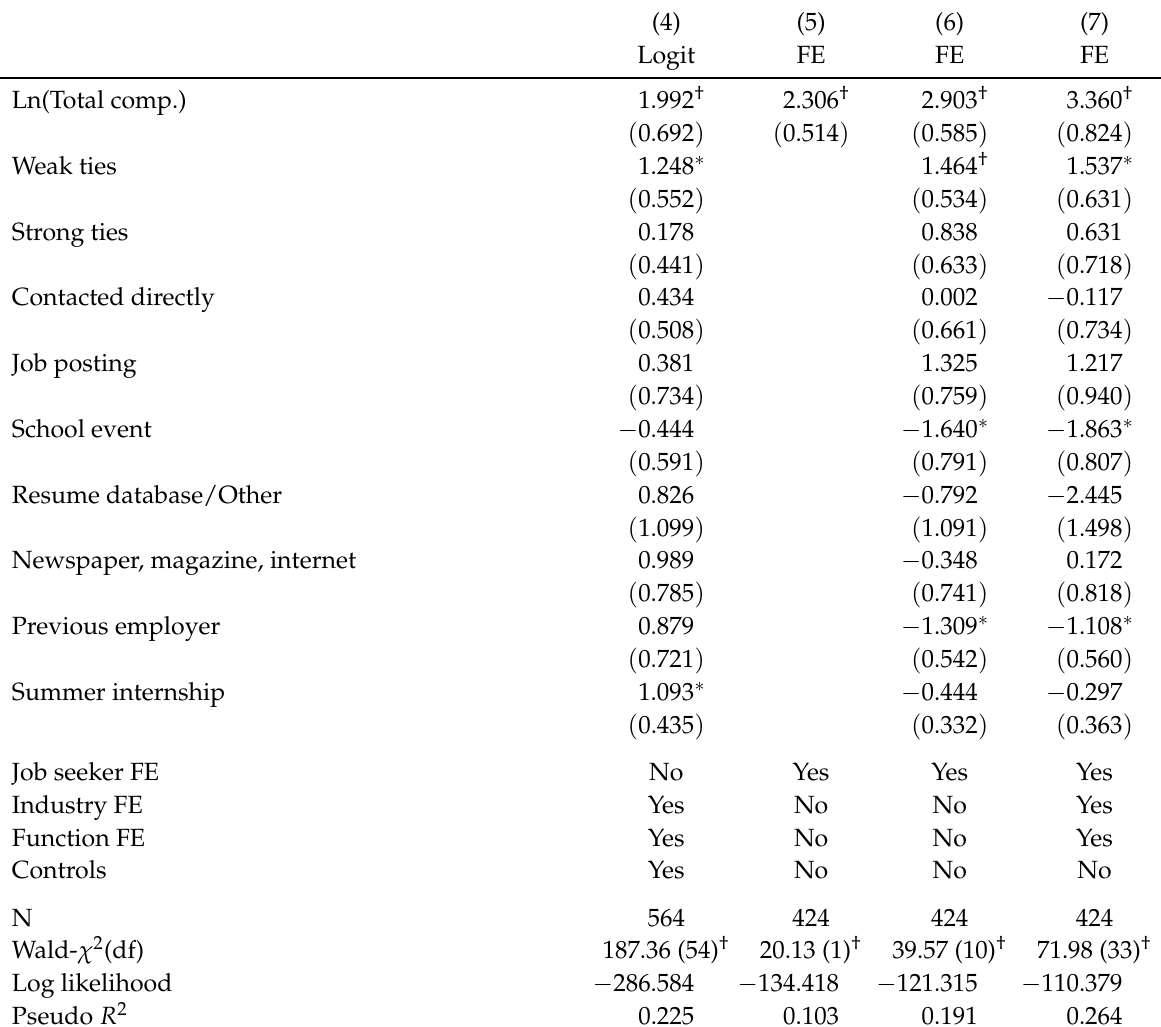
Table 3: Regression Coefficients Predicting Job